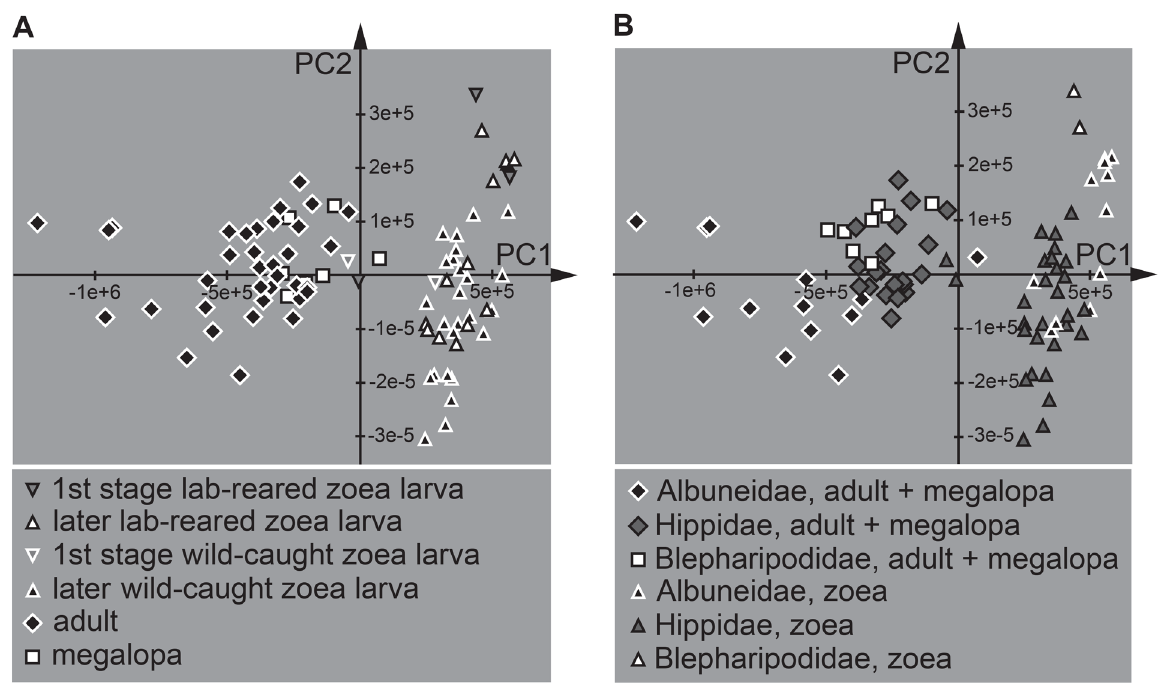
Figure 6. Plot of the first two principal components resulting from the principal component analysis (PCA) performed on the data generated by an elliptic Fourier transformation of shield shape within Hippoidea. Principal component one (PC1) explains 86.1 % of apparent diversity in the data set, principal component 2 (PC2) explains 6.6 % of the apparent diversity in the data set. Factor loadings given in the Appendix (App. 2). A : Grouping of specimens according to developmental stage and in case of the zoea stages also whether the material originated from the wild or from a lab-rearing. B : Grouping of specimens according to three major ingroups of